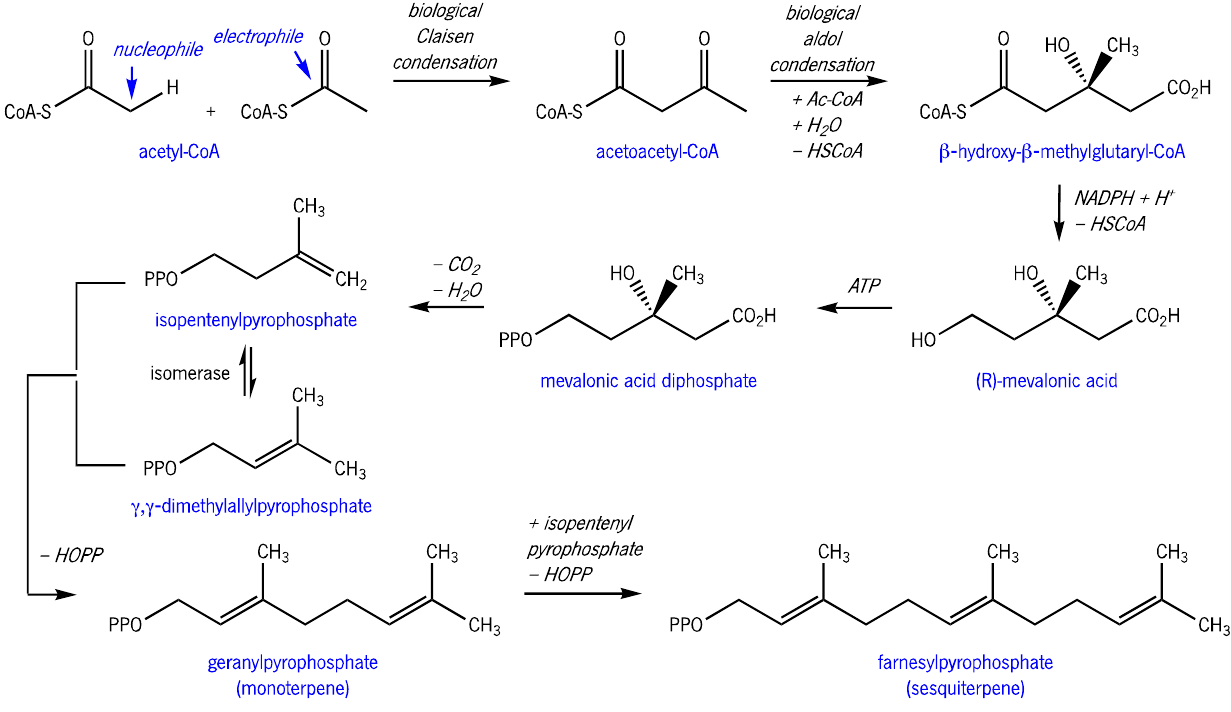
Figure 3. Monoterpene and sesquiterpene biosynthetic pathways. (CoA, coenzyme A; NADPH, reduced form of nicotinamide adenine dinucleotide phosphate; ATP, adenosine triphosphate; HOPP, hydroxy-pyrophosphate; PP, -P(=O)(OH)-O-P(=O)(OH) 2 (adapted from